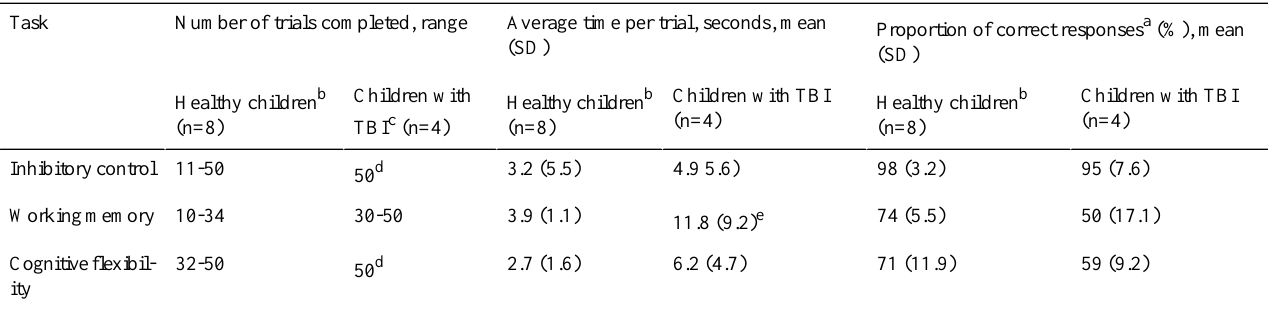
Table 4. Virtual reality–based interactive cognitive training performance of healthy children and pediatric patients with traumatic brain